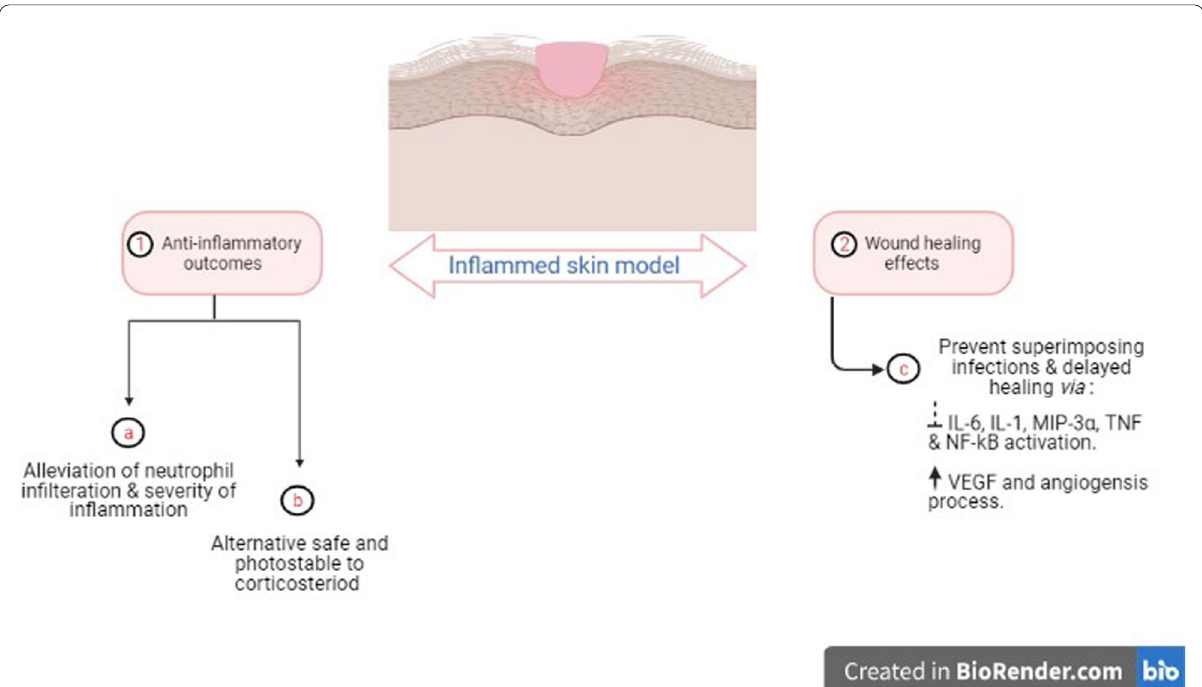
Fig. 2 Summary of the action mechanisms of oleic acid (OA) in modulating skin inflammation and wound healing